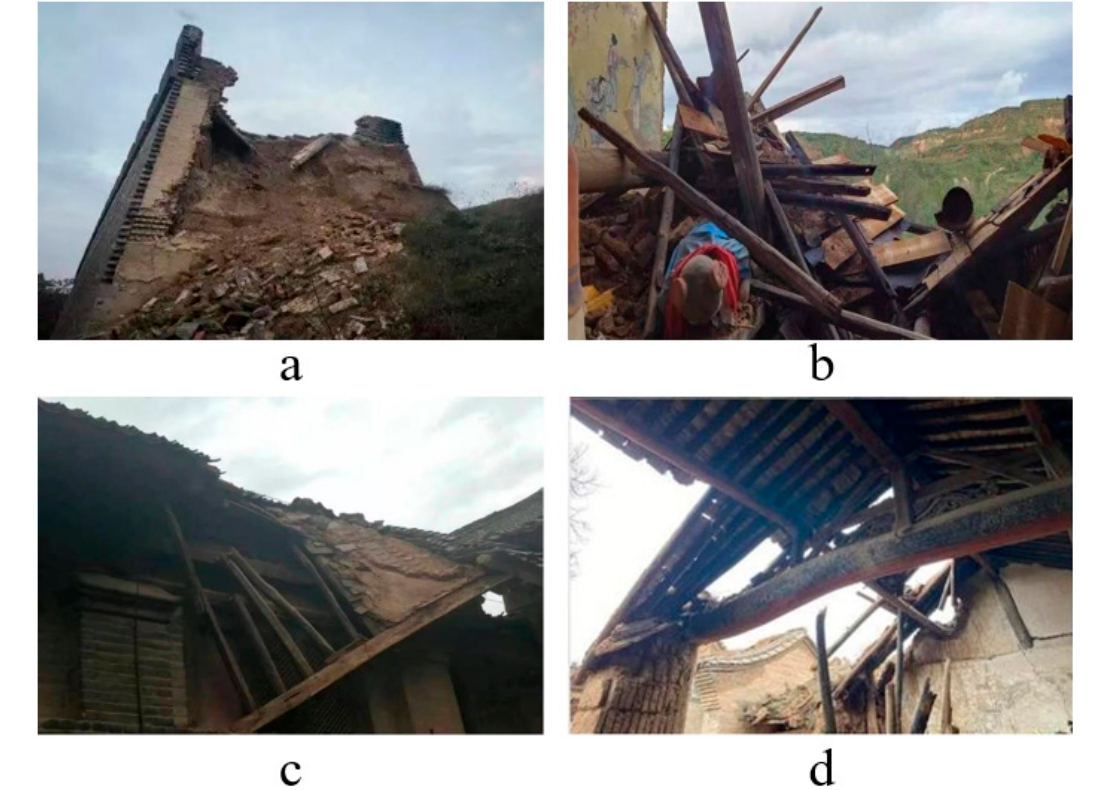
Figure 8. Damage to some ancient wooden buildings in